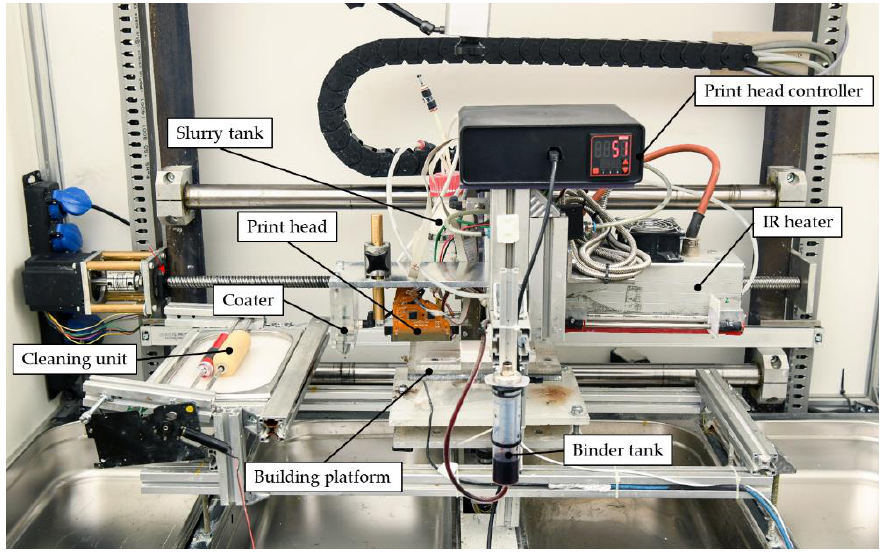
Figure 2. Slurry-based 3D printing test setup.